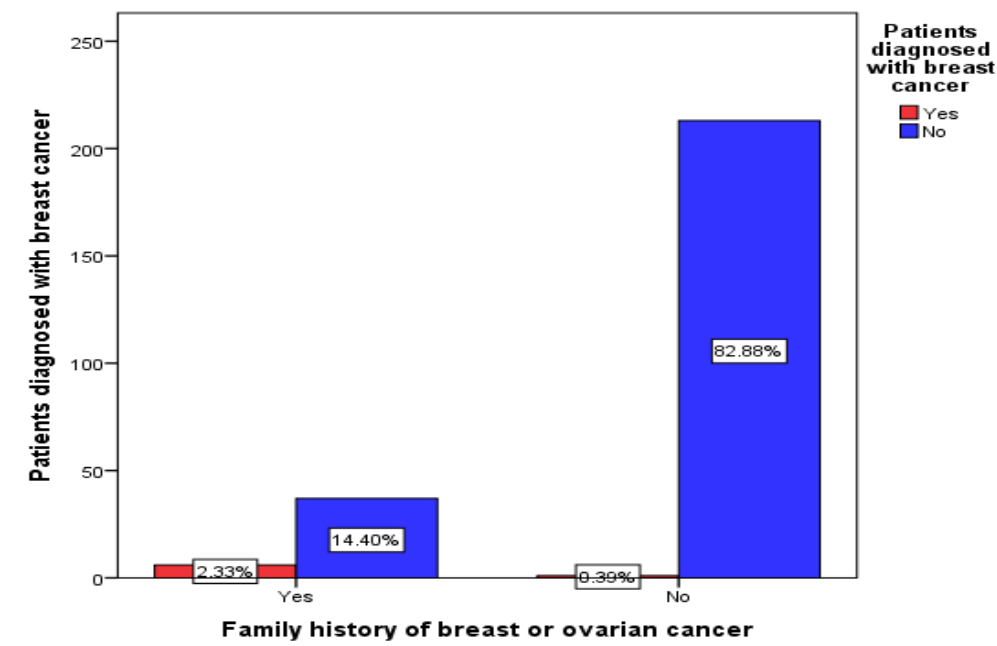
Figure 7. Frequency percentage distribution of relationship between family history and patient diagnosis of breast cancer ( p value 0.000).